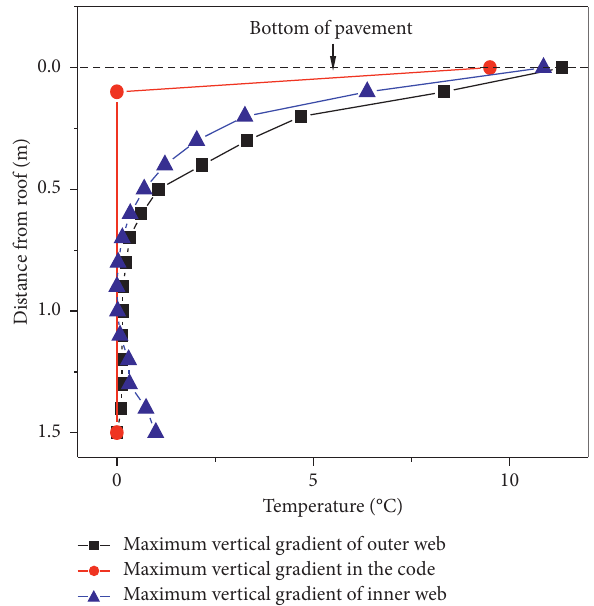
Figure 13: Distribution patterns of maximum vertical temperature